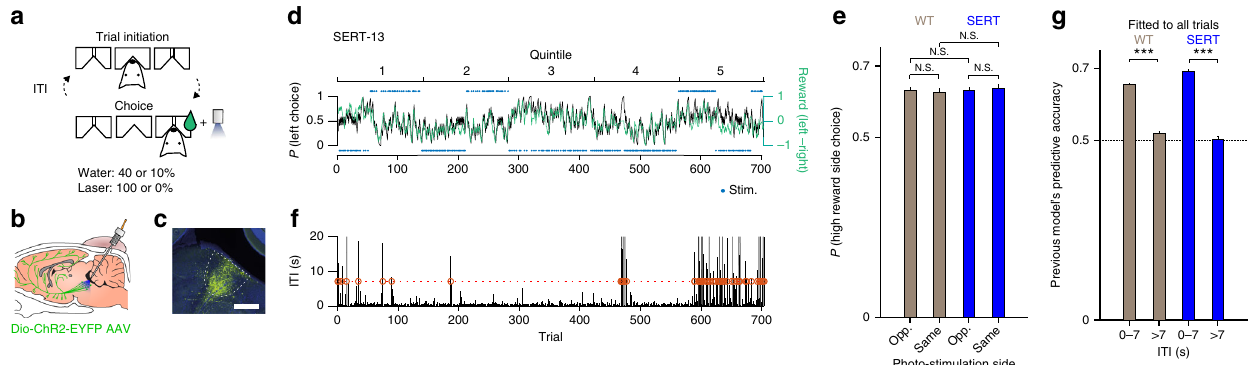
Fig. 1 Task and behavior. a The task. On each trial, a mouse was required to enter the center port (Trial initiation) and then move to one of the side ports (Choice). A reward might be delivered at the side port according to a reward schedule. The next trial started when the mouse entered the center port. The inter-trial-interval (ITI) is de fi ned as the time from when the mouse left the side port until it entered the center port to initiate the next trial. In a given block of trials, one side port was associated with a higher reward probability per trial (0.4) than the other (0.1), while photo-stimulation was always delivered at one of the side ports. b A schematic of the optogenetic stimulation. In SERT-Cre mice, 5-HT neurons expressed ChR2-YFP (green) and could be photoactivated with blue light. c A fl uorescence image of a parasagittal section shows localized ChR2-YFP expression (YFP = green, DAPI = blue) in the DRN. The white bar indicates 500 μ m. d Time course of mouse choice behavior in an example session. The probability across trials of choosing the left port (black solid line) is overlaid with the collected reward bias (green line) for an example mouse, SERT-13. The choice probability and the reward bias were computed by a causal half Gaussian fi lter with a standard deviation of two trials. The top (bottom) light blue dots indicate photo-stimulation at left (right) port. e The probability of choosing the higher water probability side for the blocks in which the photo-stimulation was assigned to the opposite side from the higher water probability side (Opp.), and for the blocks in which the photo-stimulation was assigned to the same side (Same). The difference within WT mice, within SERT-Cre mice, and between WT and SERT-Cre mice for either condition were not signi fi cant. The error bars indicate the mean ± SEM over sessions. f ITIs in the same session as d . The red circle indicates trials with long ITIs (>7 s). g The average predictive accuracy of the existing reward and choice kernel model 17,38 when fi tted to all trials. This model captures a form of win-stay, lose-shift rule. Choices following short ITIs ( ≤ 7 s) were well predicted by the model, while choices following short ITIs (>7 s) were not. The difference between short and long ITIs was signi fi cant for both WT and SERT mice (permutation test. p < 0.001, indicated by three stars.) Images b , c are reproduced from ref. 17 (Copyright [2015],